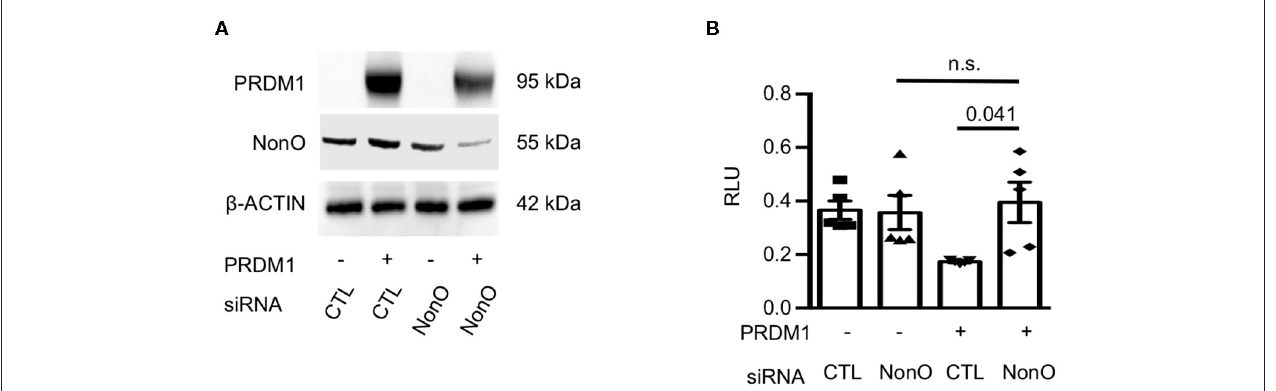
FIGURE 4 | NonO regulates IL-6 promoter activity. (A) HEK-293 cells were transfected with NonO siRNA or PRDM1 expressing plasmid. The knockdown efficiency of siRNA and PRDM1 level was verified by immunoblott analysis. β - actin was used as a loading control. Gel image is a representative from two independent experiments. (B) The IL6 promoter activity under indicated conditions was determined by luciferase reporter gene analysis. pGL4.25 were used as control vectors. Mean values of relative luciferase unit (RLU; normalized on Renilla luciferase) from three independent experiments. Bar is a mean ± SEM ( n = 4). Significance determined by unpaired t